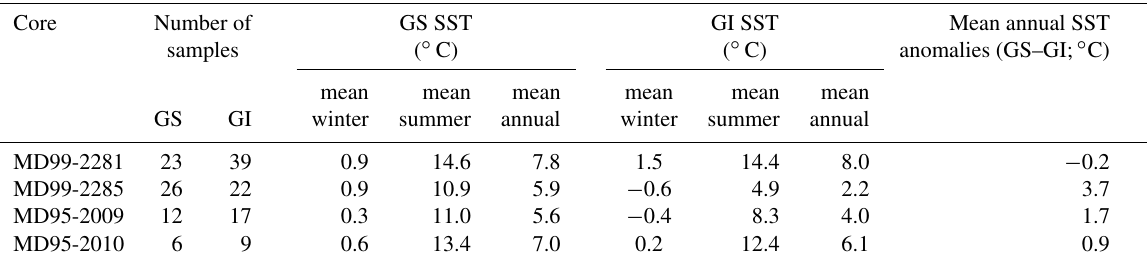
Table 1. SST anomalies. Core Number of GS SST